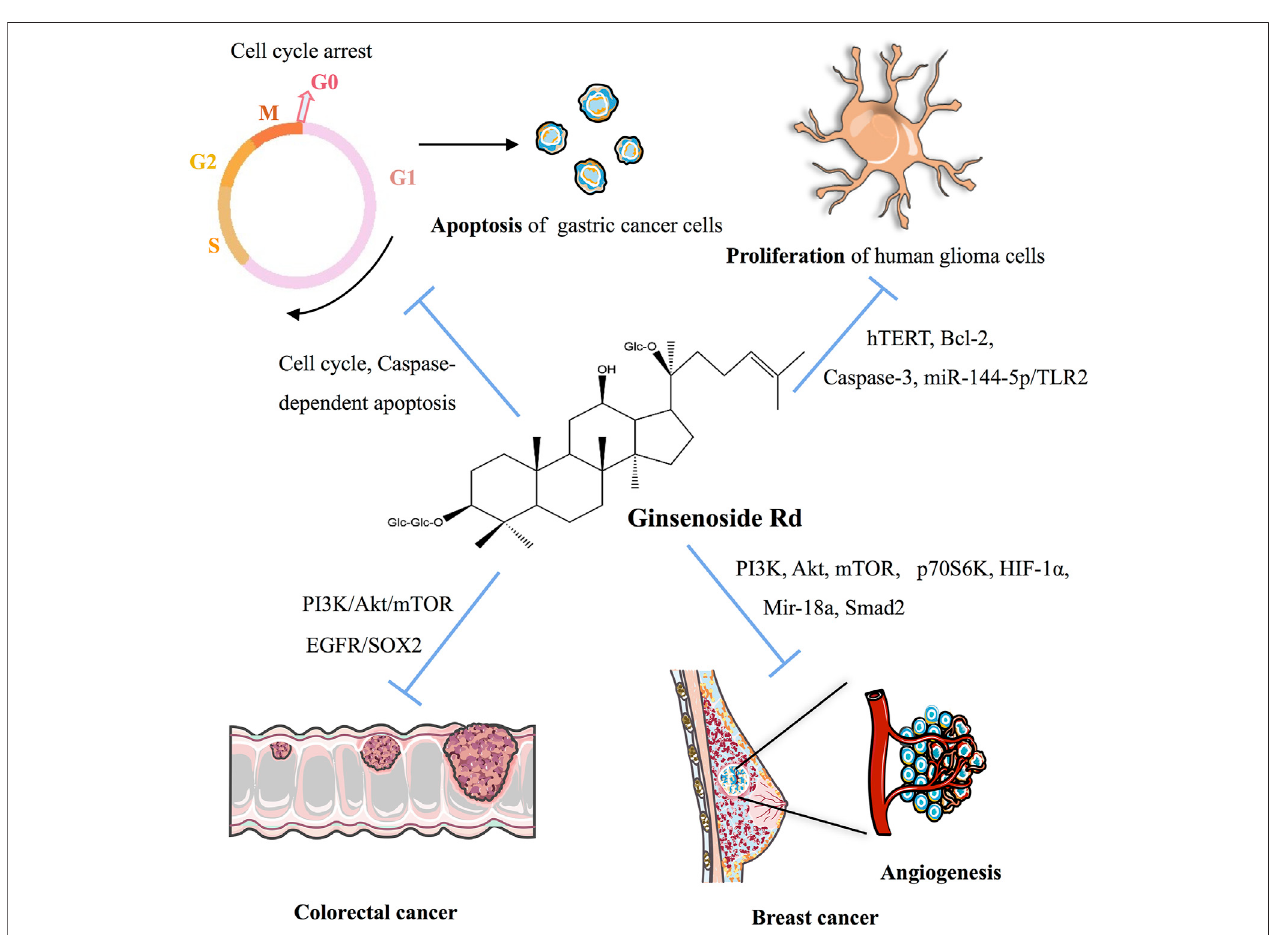
FIGURE 3 | Molecular mechanism of ginsenoside Rd on anticancer activity in multiple